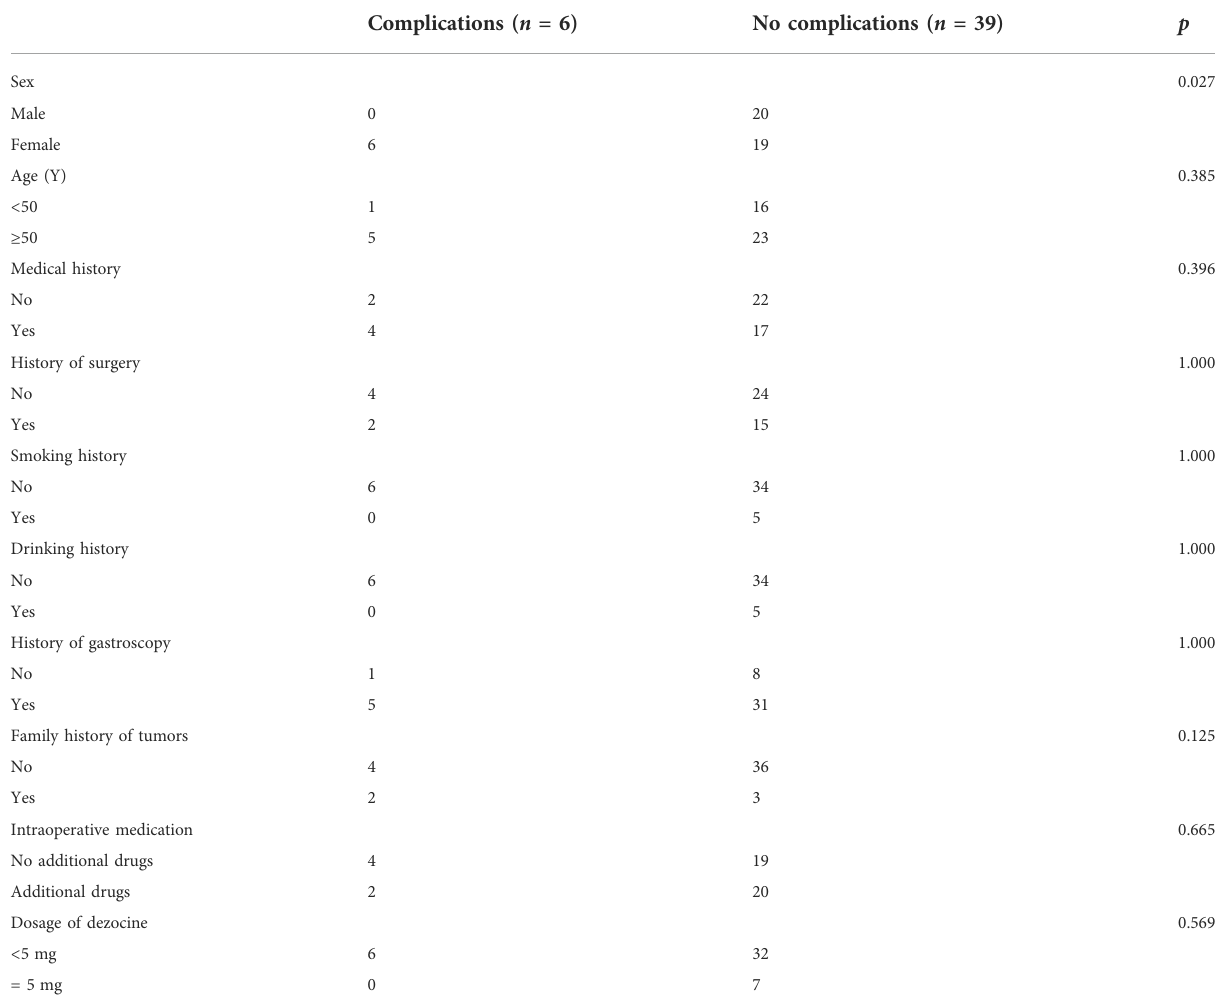
TABLE 3 Factors related to complications in the SEG (Fisher ’ s exact probability